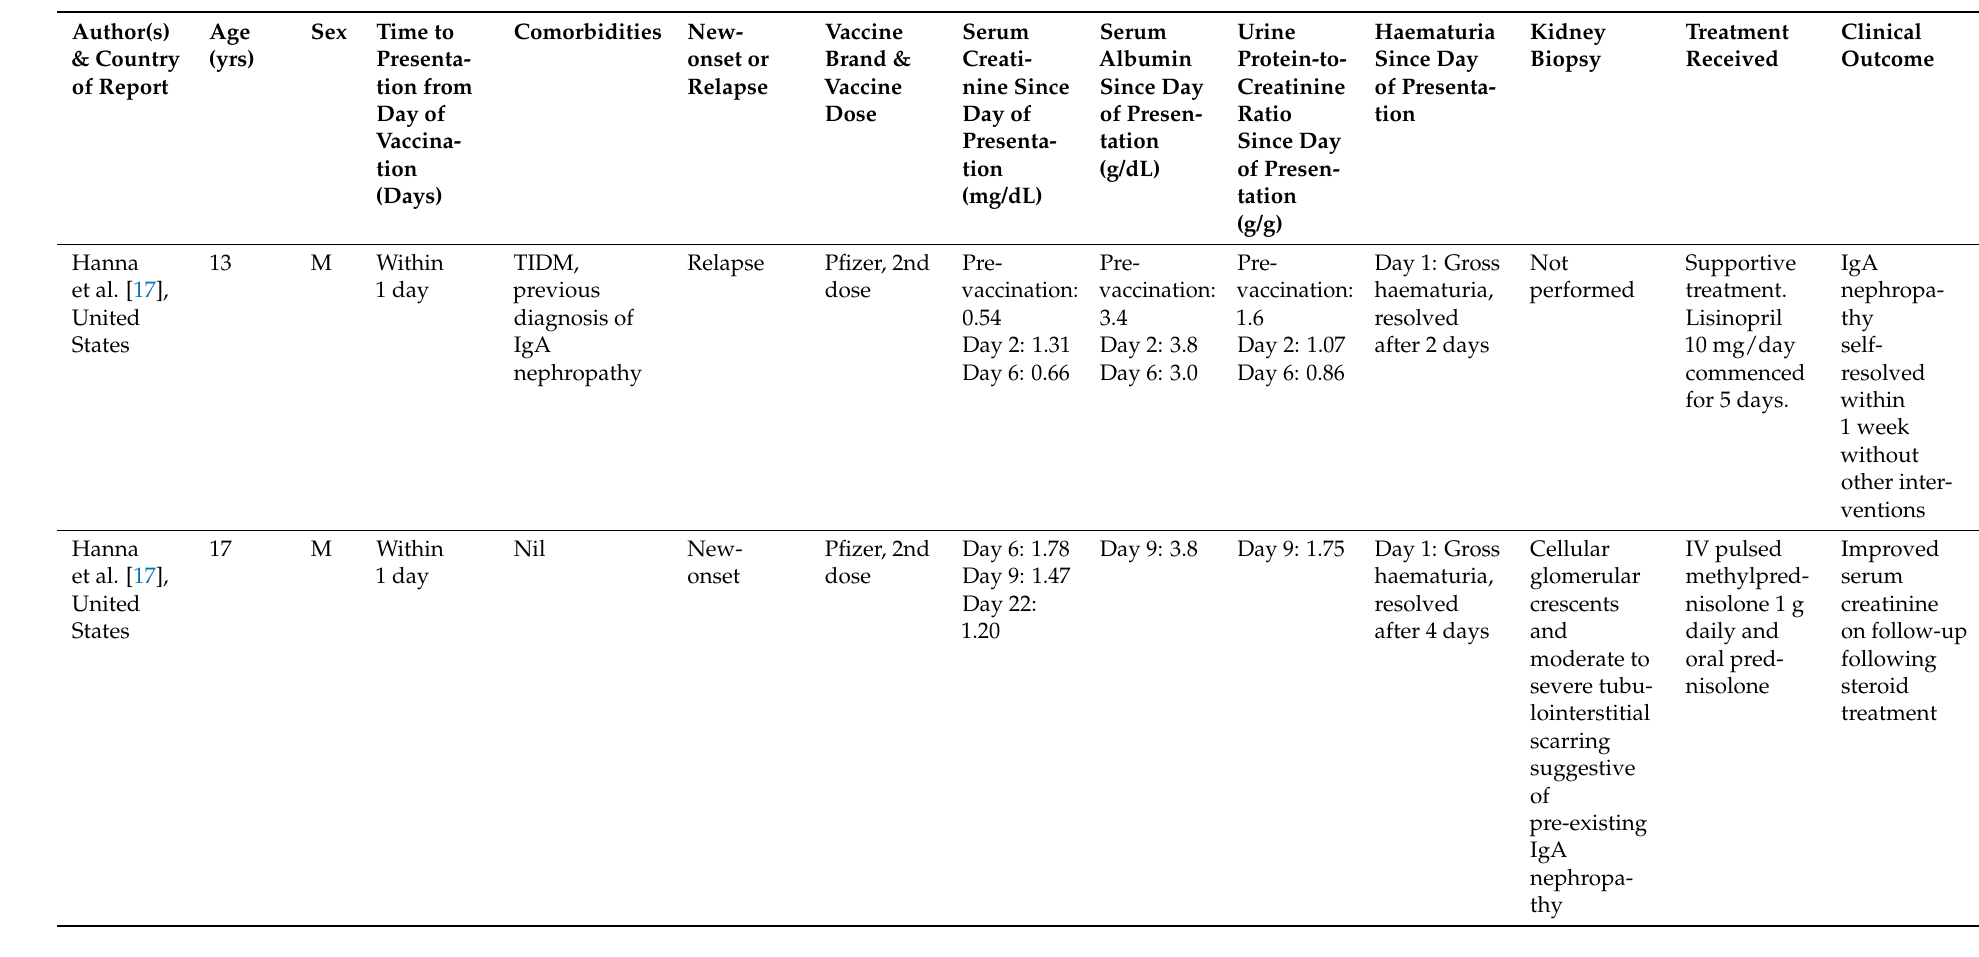
Table 1. Demographics and outcomes of children and adolescents with new-onset and relapsed IgA nephropathy following COVID-19